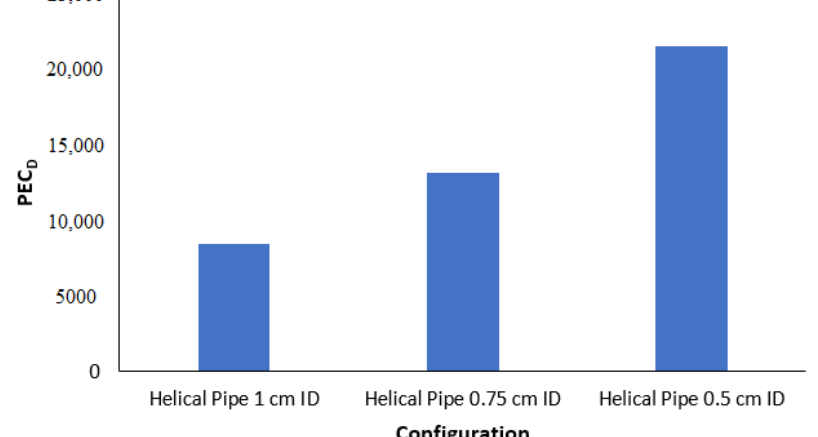
Figure 13. PEC D of the helical pipe configuration with various IDs.